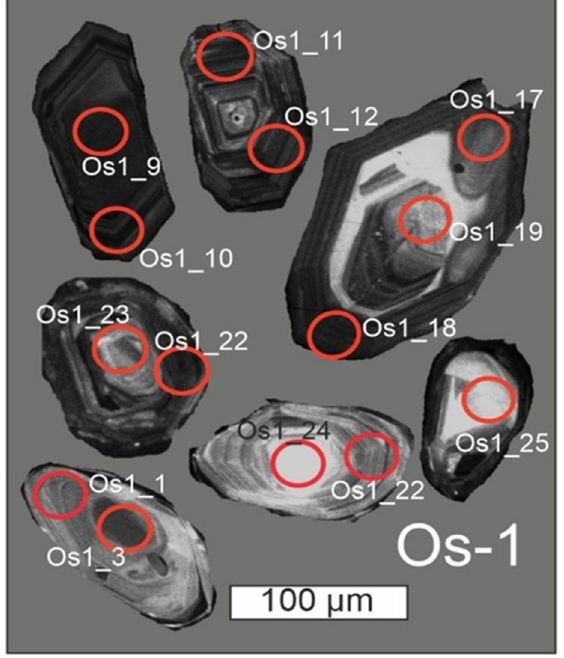
Minerals 2021 , 11 , x FOR PEER REVIEW Figure 4. Cathodoluminescence (CL) images of selected zircon crystals from granitoid from Osielec granite. Selected analytical spots and analysis numbers (see Table 6) are marked as circles.